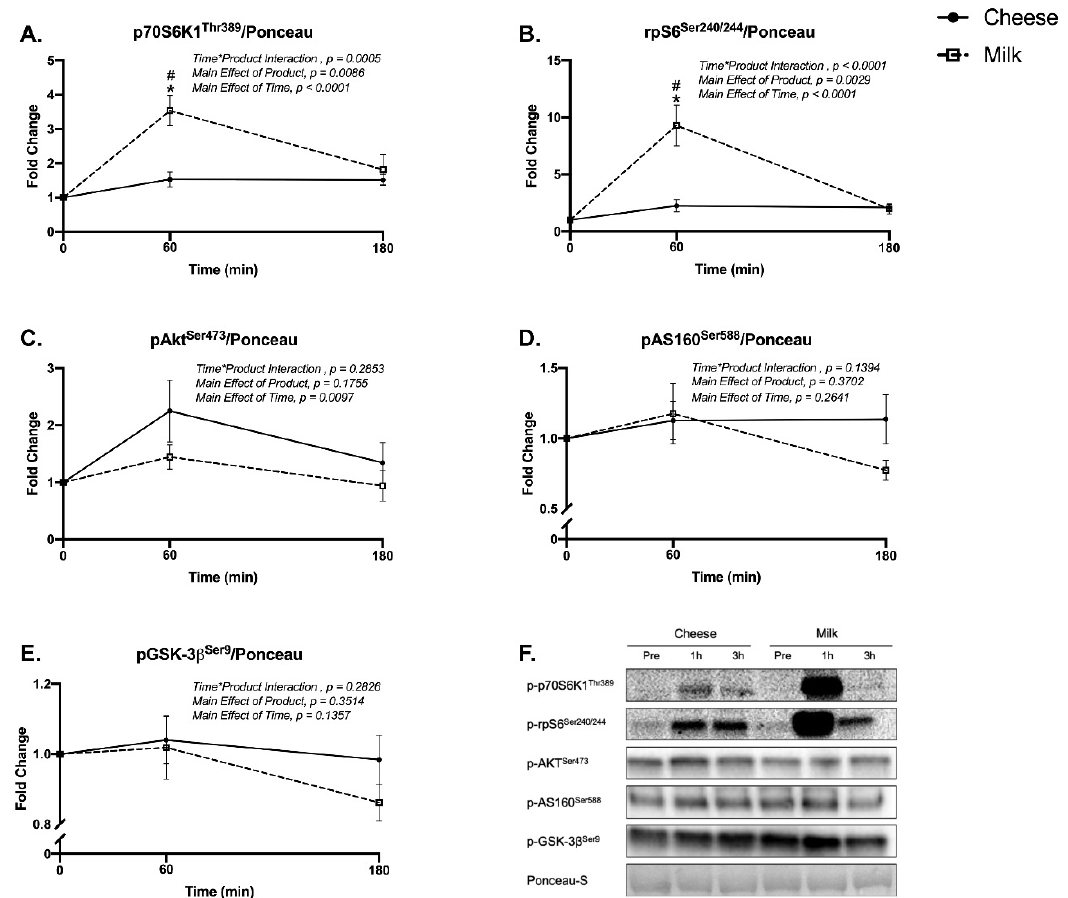
Figure 4. Skeletal muscle protein expression using immunoblotting for ( A ) p70S6K1(Thr389), ( B ) rpS6(Ser240/244), ( C ) Akt(Ser473), ( D ) AS160(Ser588), and ( E ) GSK-3 β (Ser9) in the fasted state (0 min) and at 60 and 180 min following the ingestion of either cheese (solid line) or milk (dotted line) in men and women. Panels ( A , B ) are data for n = 24 while for ( C – E ) only n = 8 (4 M, 4 F) were analyzed. Panel ( F ) are representative images of immunoblotting. Phosphorylated protein levels were normalized to Ponceau-S. Different from baseline (0 min) for milk (*), p < 0.05. # , Different between groups at the specific time point, p < 0.05.